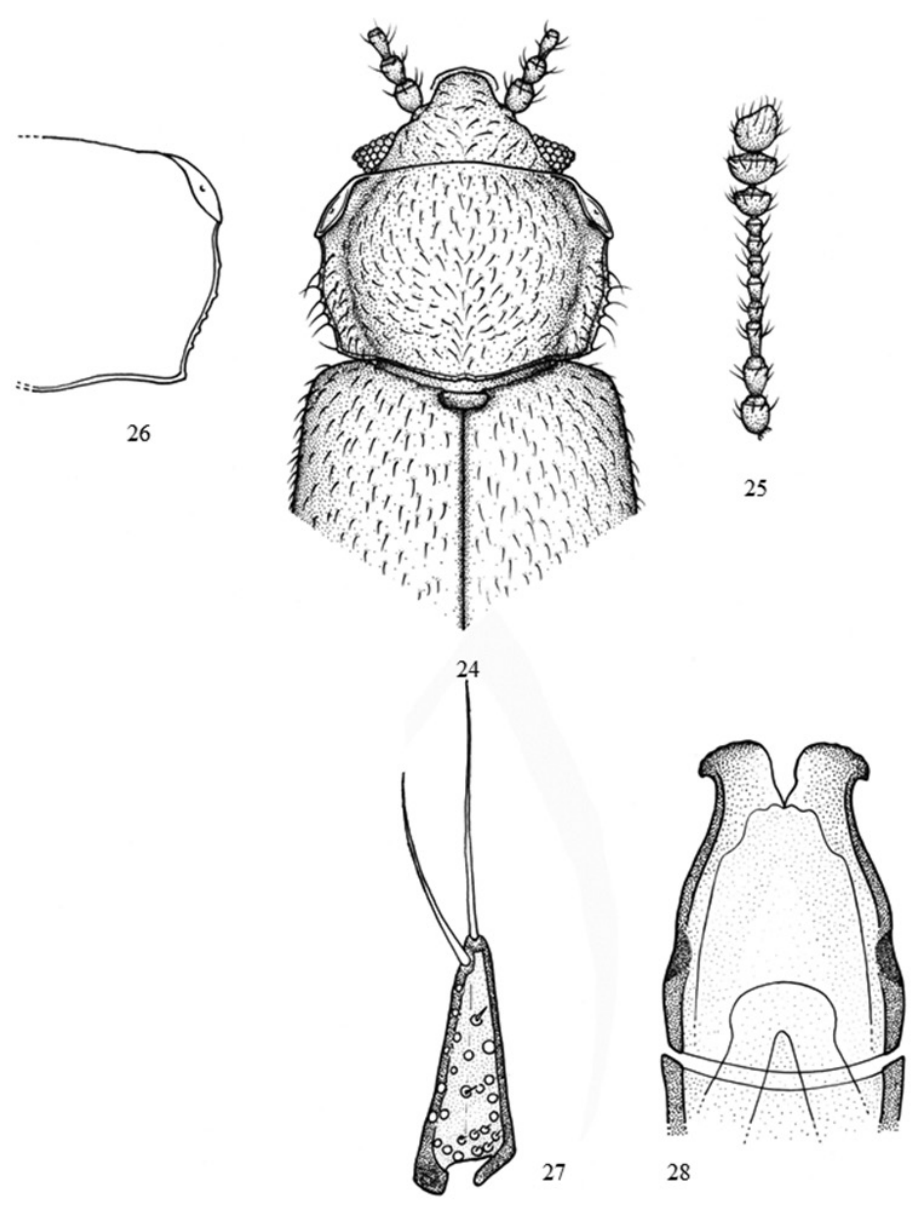
No material examined. Description (see Lyubarsky 2013). Biology. Unknown. Distribution. Réunion Island (Lyubarsky